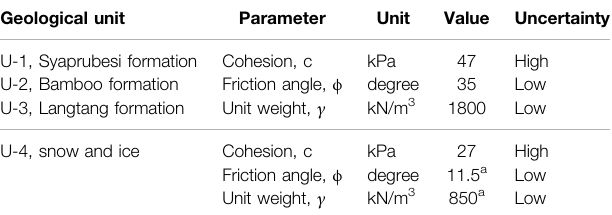
TABLE2| Parametersusedinthecriticalaccelerationmodelandtheiruncertainty. Geological